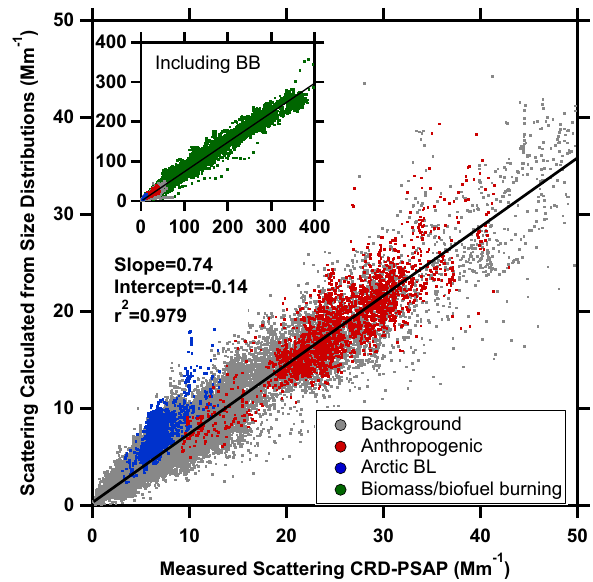
Figure 51655 Fig. 5. Aerosol scattering coefficient calculated from measured par- ticle size distributions as a function of scattering calculated from di- rect extinction and absorption measurements. Line is a linear least- squares regression to all ) , F mr . /(SO = + NO − 4 4 3